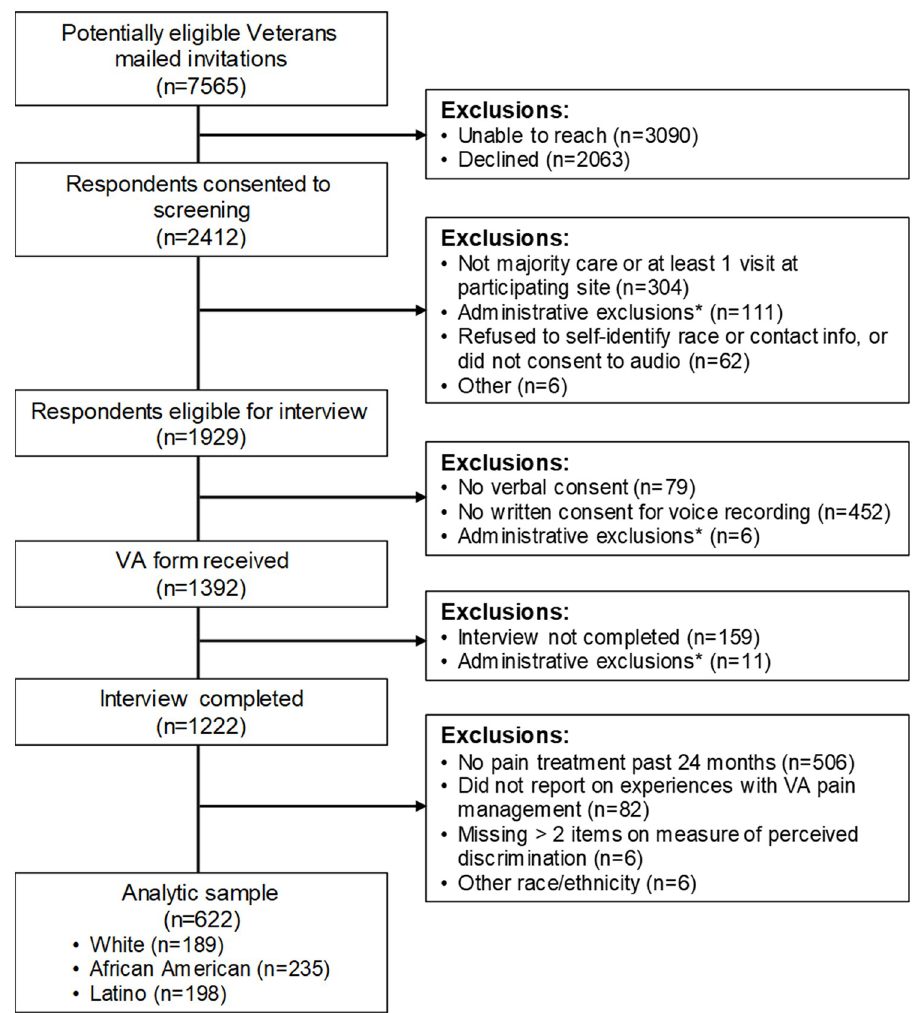
Fig 1. Participant recruitment and study enrollment. Exclusion criteria were applied sequentially. � The predominant reason for administrative exclusion was that a recruitment cell was filled by the time a potential respondent worked their way through the multi-step recruitment